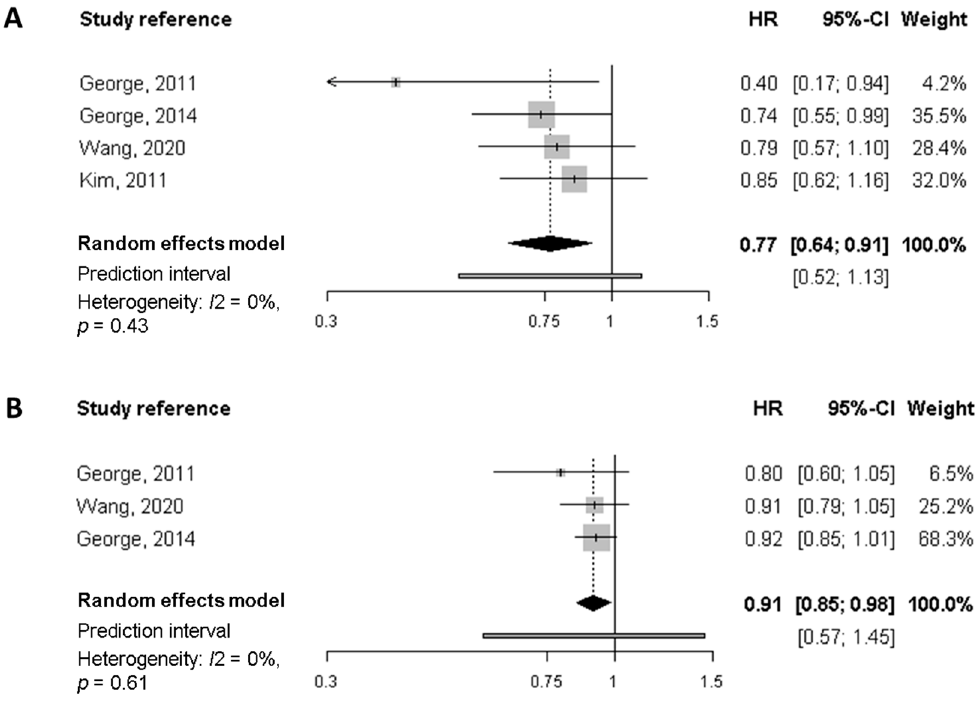
Figure 2. Meta-analysis of prospective cohort studies on the association between quality diet score and overall mortality among breast cancer survivors. ( A ) Forest plot showing pooled hazard ratios (HRs) with 95% CI for the highest diet quality (Healthy Eating Index [HEI], Alternate Health Eating Index [AHEI]) vs lowest diet quality category for overall mortality. ( B ) Forest plot showing pooled HRs with 95% CI for 10-point increase in the quality diet score and overall mortality.